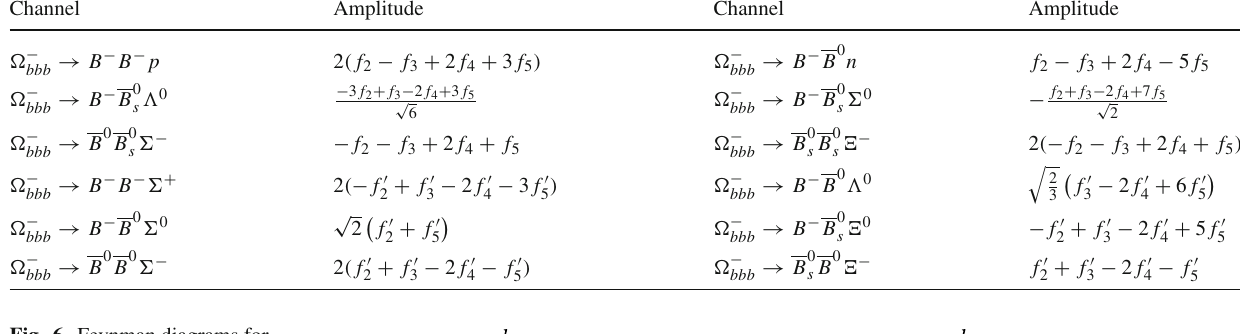
Fig. 6 Feynman diagrams for (cid:2) − decays into two B -mesons bbb and a light baryon (octet or